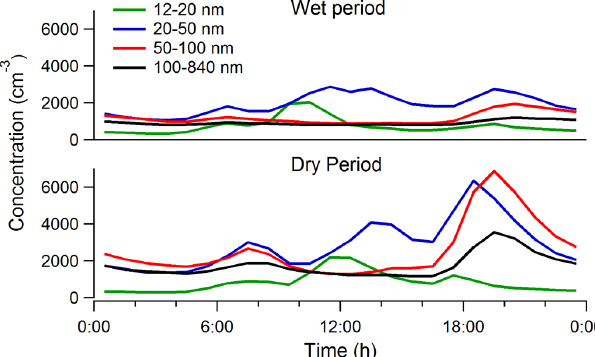
Fig. 5. Diurnal cycle of 12–20nm, 20–50, 50–100nm and 100– 840nm particle concentrations during the wet (October–April, up- per panel) and the dry (May–September, lower panel) periods.